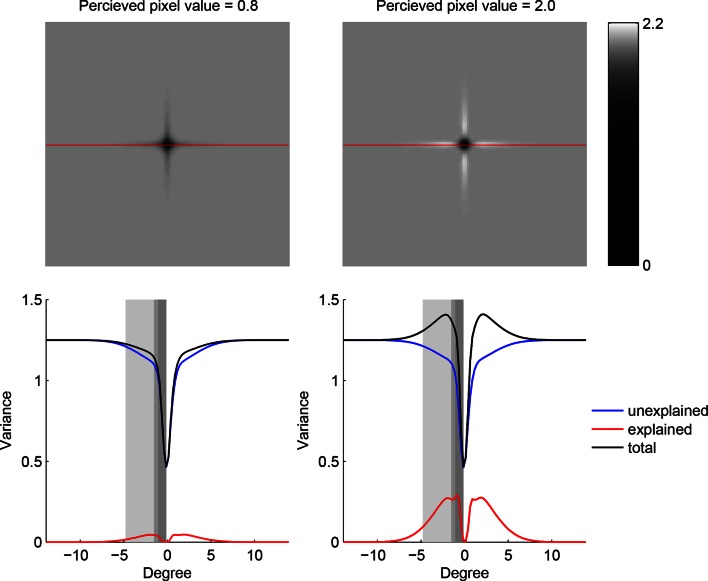
Trade-off between the two components making up total uncertainty underlying the maximum-entropy algorithm.Top row shows entropy (in bits) of the predictive distributions, H[z*|x*,D], for a grid of locations after one observation. Bottom row shows the corresponding variance decomposition (cf. Equation 1), unexplained (blue) corresponds to “noise” entropy, H[z*|x*,c,D]ℙ(c|D), explained (red) correspond to the BAS score, Score(x*|D), and total (black) coresponds to total uncertainty, H[z*|x*,D]. The widths of the gray regions correspond to the three length scales with which the three image types are constructed.